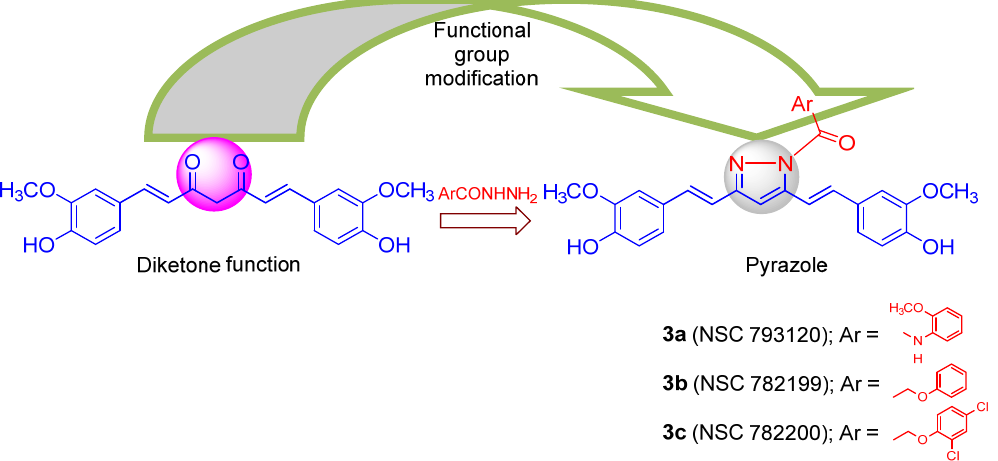
Figure 1. Structural modification of diketone function into